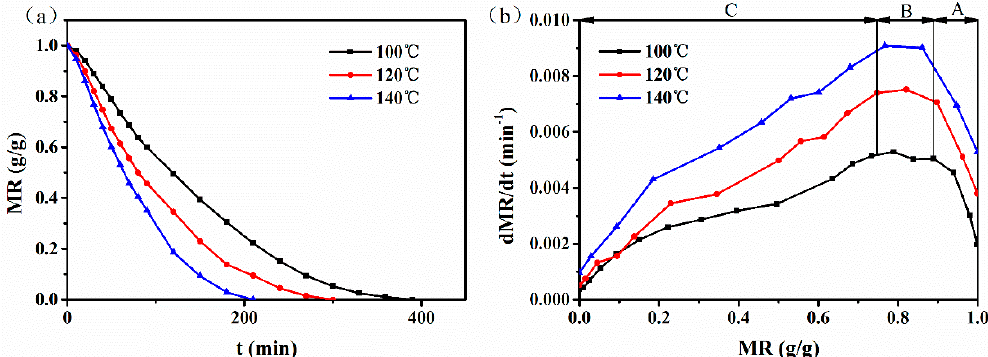
Figure 4. Drying curves of Zhaotong lignite at different temperature by hot-air drying method. ( a ) Moisture ratio vs. drying time; ( b ) drying rate vs. moisture ratio.